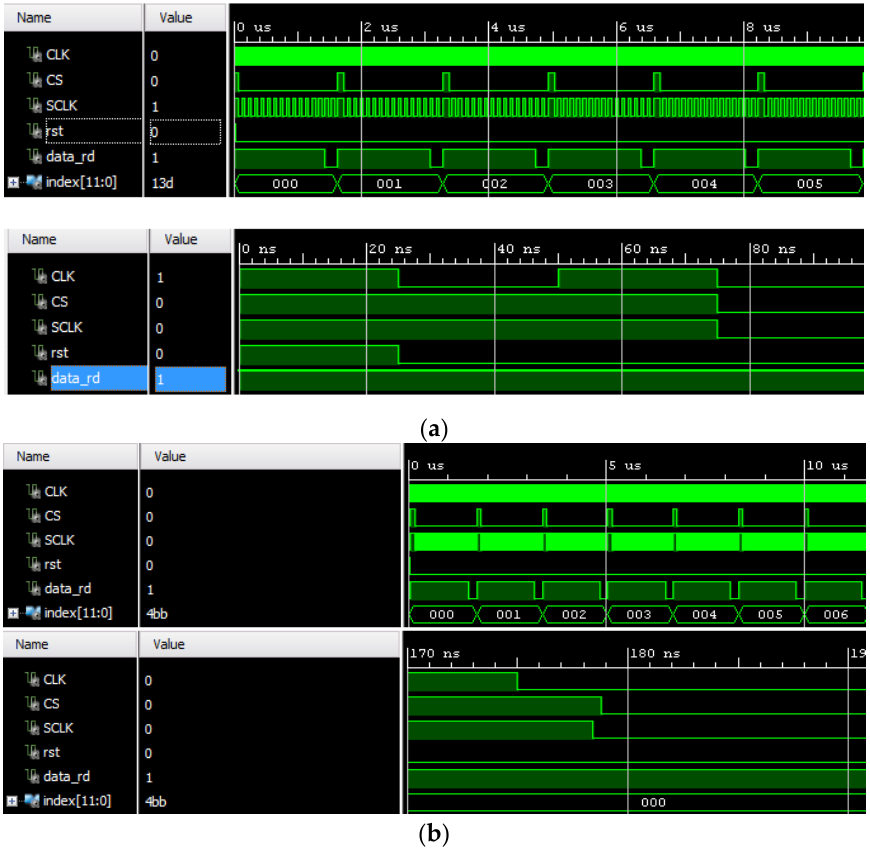
Figure 17. Simulation of VHDL code. ( a ) Prior synthesis process; ( b ) After synthesis process.